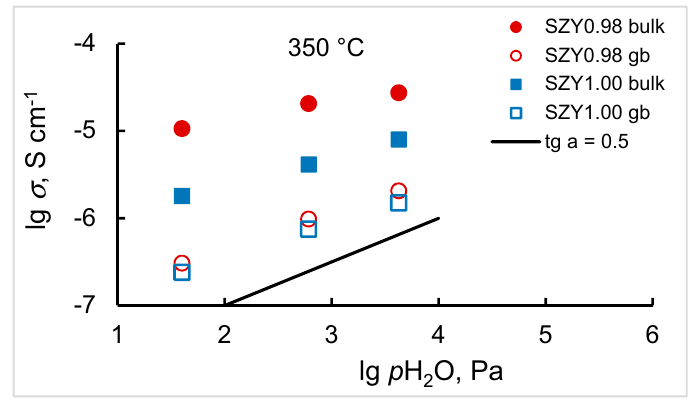
Figure 10. Bulk and grain boundary conductivity vs. humidity for SZY0.98 and SZY1.00 at 350 ◦